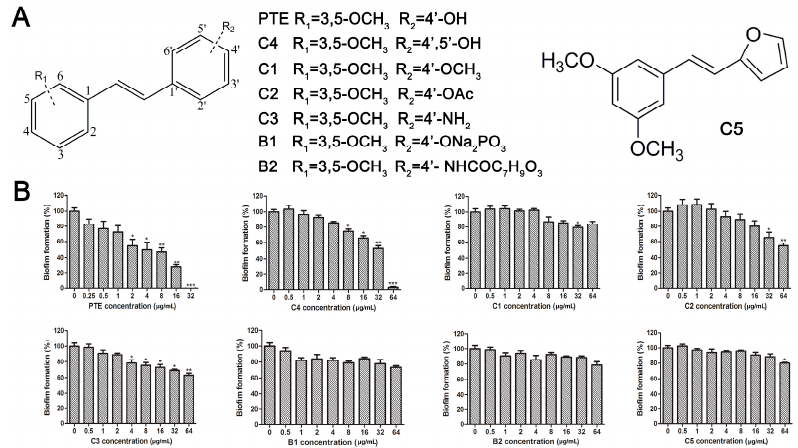
Figure 2. Effects of PTE and analogues C1–C5, B1, B2 on biofilm formation. ( A ) Chemical structures of PTE and analogues C1–C5, B1, and B2 are shown. The structures of analogue C1–C5, B1, and B2